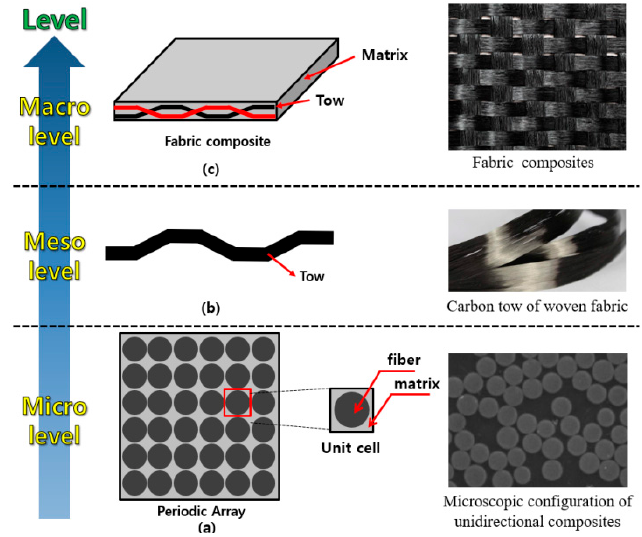
Figure 2. Schematic diagram of a multiscale model: ( a ) Micro level; ( b ) Meso level; ( c ) Macro level [22 – 24].